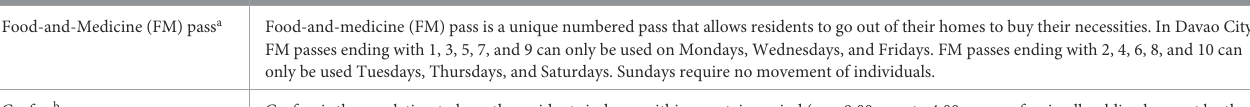
TABLE 1 Government guidelines implemented in the model and their description. Government